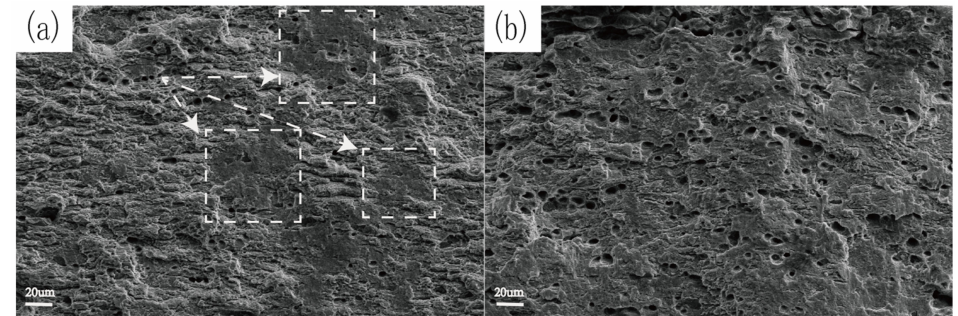
Figure 7. Fracture morphologies for Alloy 1 (aged for 61 h at 120 ◦ C) and Alloy 5 (aged for 90 h at 120 ◦ C) in 3.5% NaCl + 0.5% H 2 O 2 aqueous